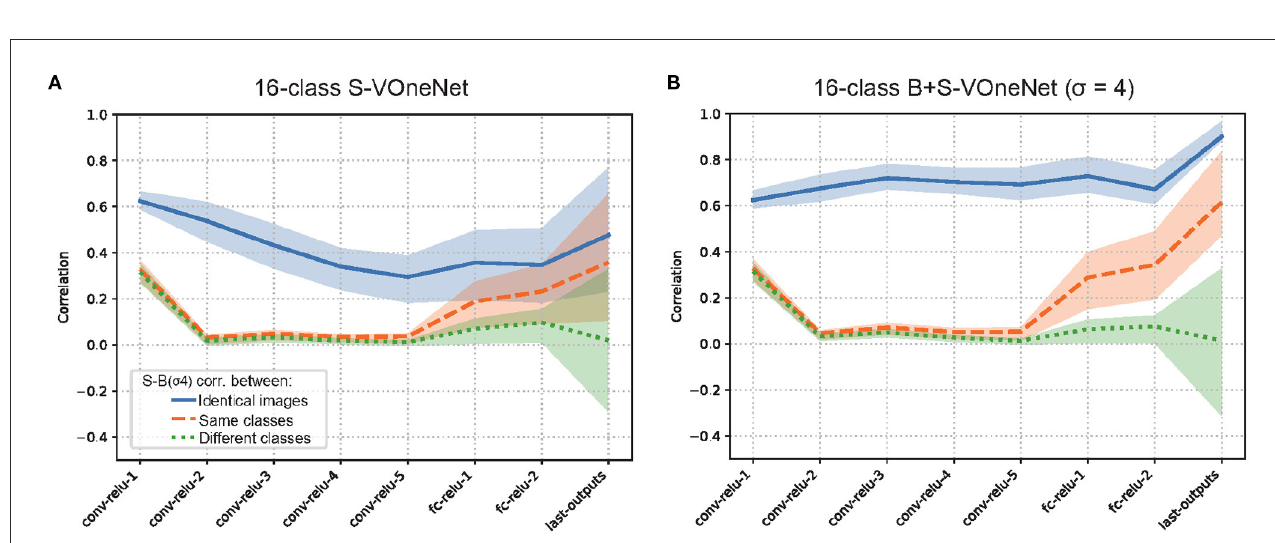
FIGURE6 Representational similarity of sharp (unblurred) and blurred image inputs for S-Net (A) and B+S Net (B) . VOneNet. The pattern of results is similar to Figure